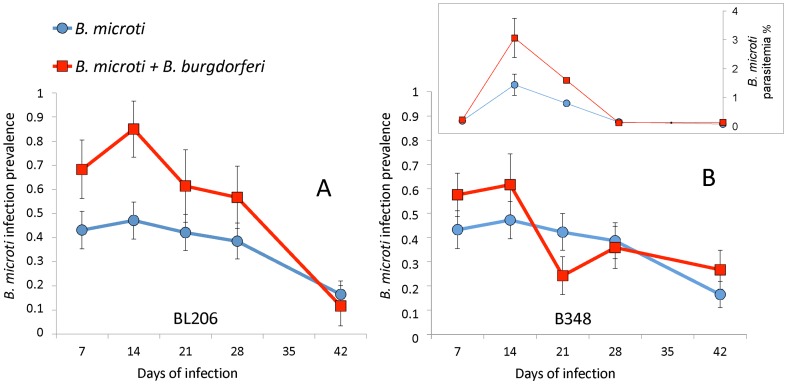
Effect of coinfection on larval acquisition of Babesia microti.The results show the prevalence of B. microti in xenodiagnostic ticks that fed on mice infected with B. microti alone compared to mice coinfected with B. microti and Borrelia burgdorferi strain BL206 (A) or B. burgdorferi strain B348 (B). B. microti parasitemia in mice infected with B. microti alone or B. microti and B. burgdorferi strain B348 are shown in inset above B. The error bars indicate 95% confidence intervals.